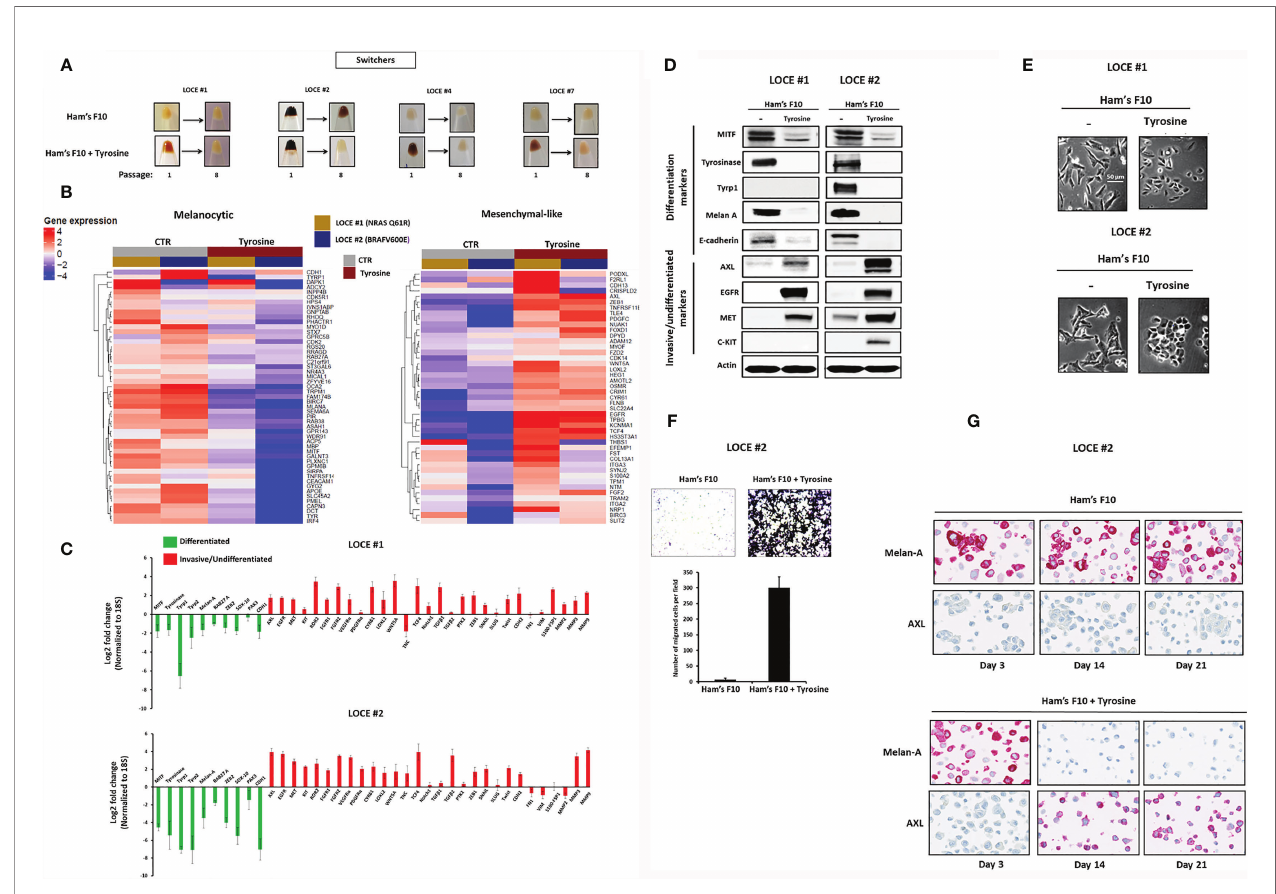
FIGURE 2 | Tyrosine promotes a drift towards a mesenchymal-like/undifferentiated phenotype. (A) Comparison of visible pigmentation of cell pellets from four primary cultures (LOCE #1, 2, 4 and 7) (group of switchers) in low tyrosine medium (Ham ’ s F10, 10 µM) and high tyrosine medium (Ham ’ s F10, 100 µM/supplemented with tyrosine) at passage 1 and 8. (B) Heatmap of genes in the Hoek signatures that are differentially expressed in the primary melanoma cultures (LOCE #1 and 2) at passage 8 for both the melanocytic and mesenchymal-like clusters in the two culture media (Ham ’ s F10 and Ham ’ s F10 supplemented with tyrosine) measured by RNA-seq. (C) Log2-fold change values determined by Real-time quantitative PCR of main genes implicated in cell differentiation (melanocytic phenotype) (green) and undifferentiation/invasion (mesenchymal-like phenotype) (red) in the primary melanoma cultures (LOCE #1 and 2) (passage 8) (Fold change was calculated based on gene expression in Ham ’ s F10 high tyrosine relative to Ham ’ s F10 low tyrosine - Data are presented as Mean ± SEM of three independent experiments normalized to 18S). (D) Comparative protein expression (representative western blot) of main differentiation markers and RTK expression ( b actin served as a loading control) and (E) comparison of cell morphology within the two primary cultures (LOCE #1 and 2) established in the 2 culture media (Ham ’ s F10 and Ham ’ s F10 supplemented with tyrosine) (passage 8). (F) Effect of tyrosine on cell migration activity in the primary melanoma culture LOCE #2. Upper panel show representative regions of the chamber fi lters with crystal violet-stained cells. The number of migrated cells per fi eld was calculated from three independent experiments. Data are presented as means±SEM. (G) Immunostaining for melan-A and AXL in low tyrosine medium and high tyrosine medium at day 3, 14 and 21 days in the primary melanoma culture LOCE #2 (magni fi cation,